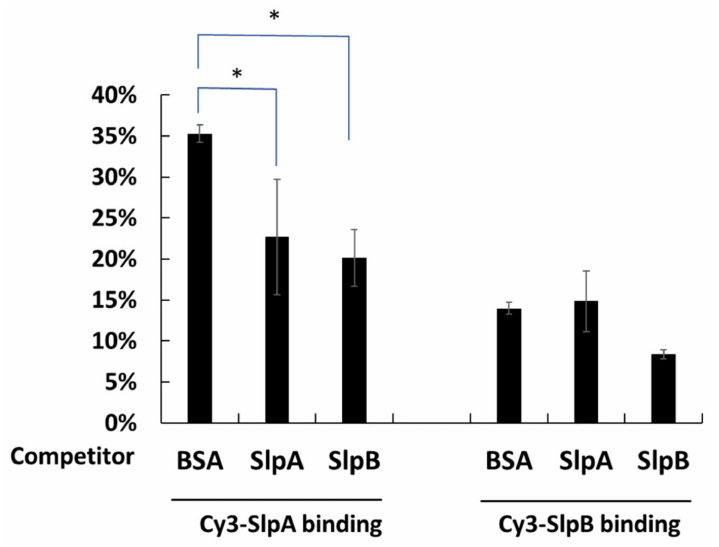
Figure 4. Bindings of Cy3 SlpA prepared from L. acidophilus JCM 1132 and Cy3 SlpB prepared from L. brevis JCM 1059 to THP-1 DC with or without 10 × non-labelled SlpA and SlpB. (Means ± SD. * p <